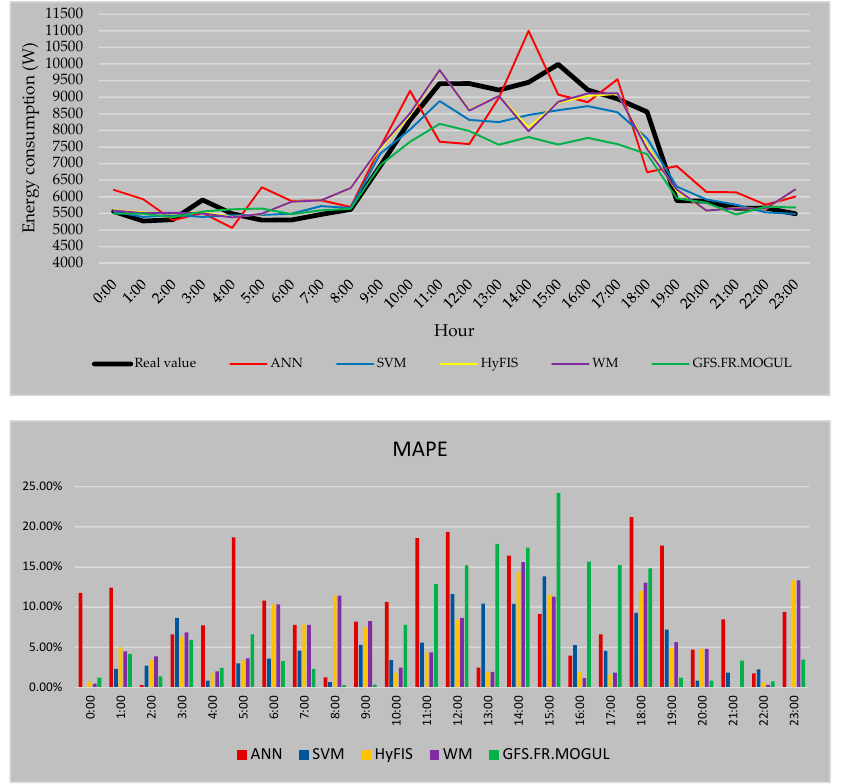
Figure 12. Forecasted values and error of the methods using the 1st data preparation strategy. Appl. Sci. 2019 , 9 , x FOR PEER REVIEW